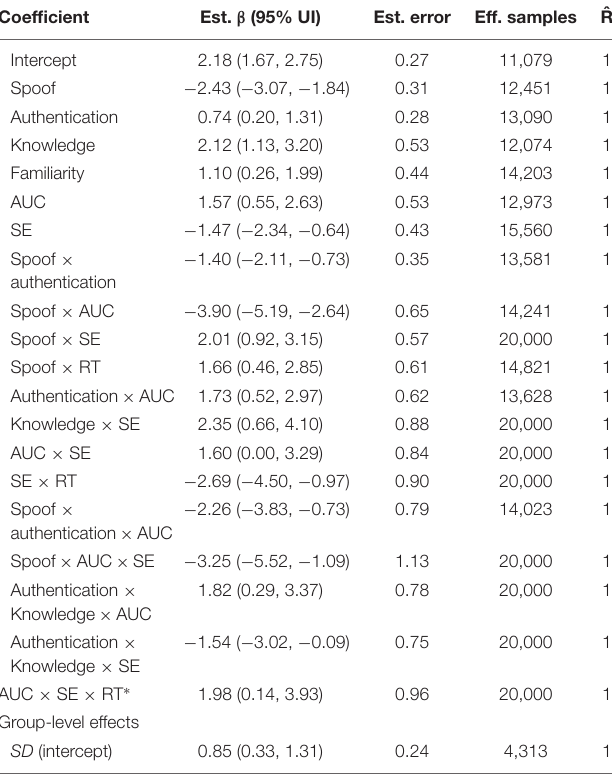
TABLE 2 | Two-factor model coefficient estimates from those estimated to have credible effects different than zero. Coefficient